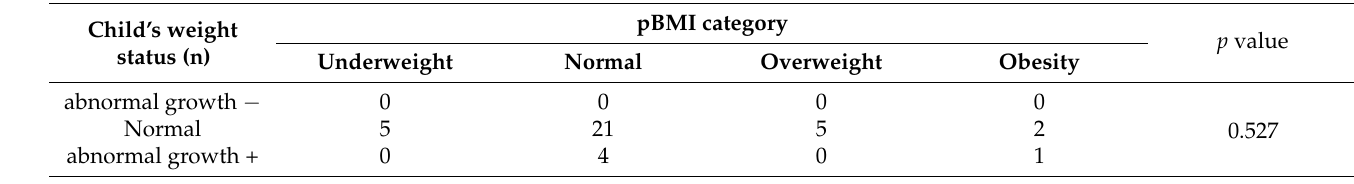
Classification by centile charts: weight-for-age, 12 months